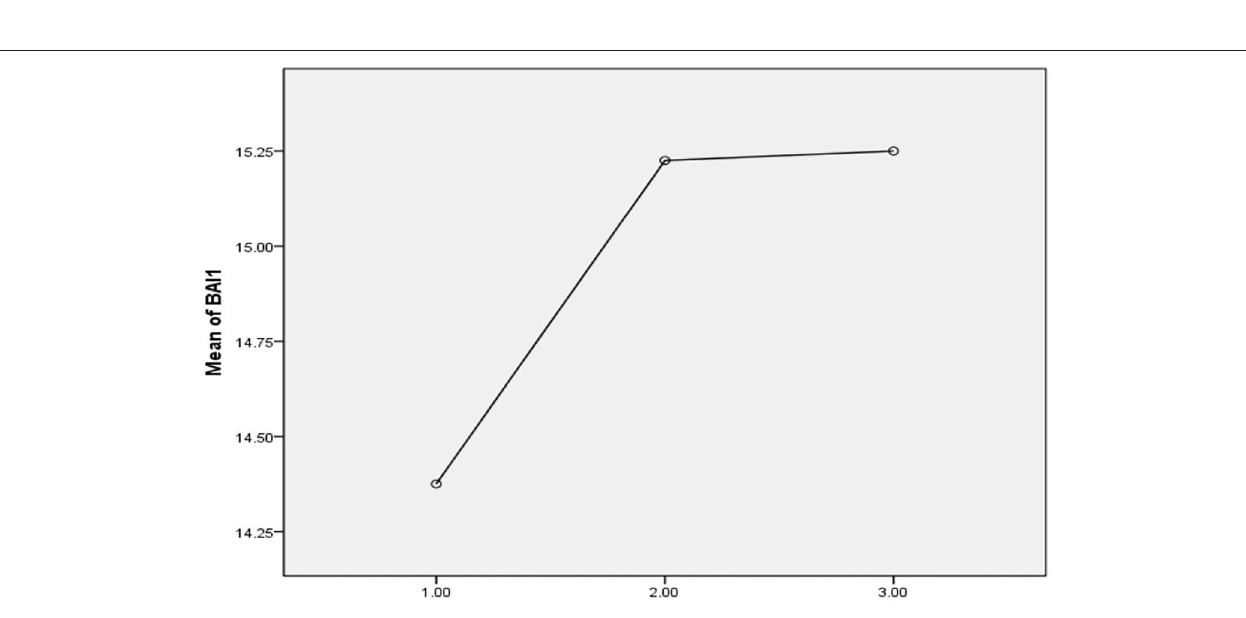
FIGURE 8 | Illustrative mean difference of anxiety disorder between the pretesting phase (T-0), posttesting phase (T-1), and follow-up phase (T-2) in Pakistan students during the COVID-19 epidemic lockdown ( N =